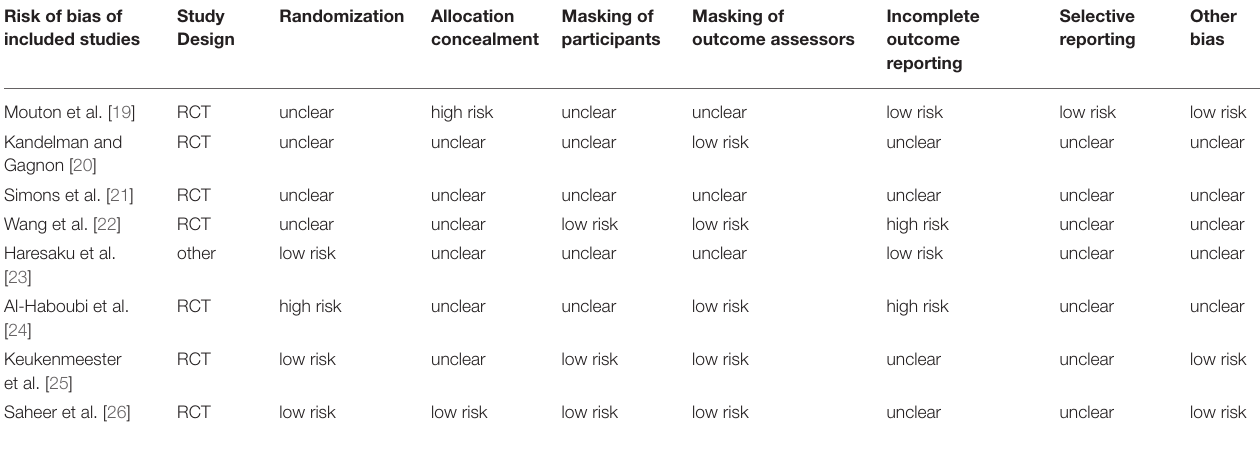
TABLE 3 | Summary of risk of bias of included